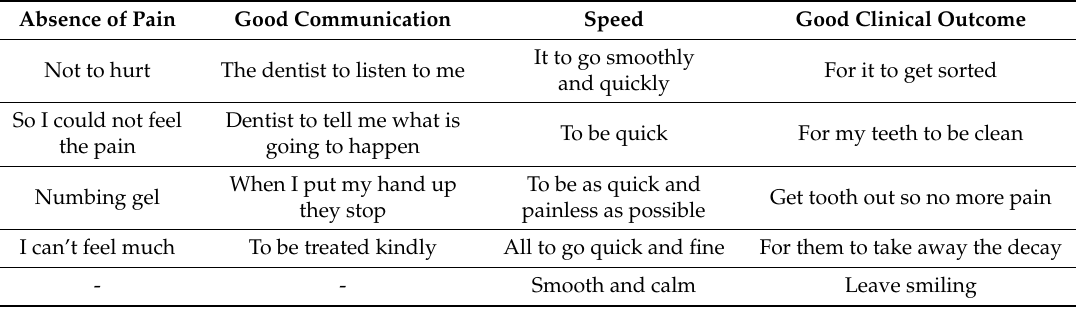
Table 3. Examples of things children said they wanted to happen at their dental visit, within four themes. Absence of Pain Good Communication Speed Good Clinical